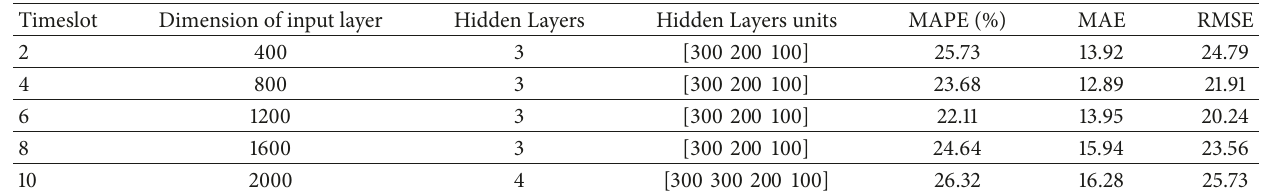
Table 1: Architecture structure for SSAEs. Table 1 is reproduced from F. Lei et al. (2018) (under the Creative Commons Attribution License/public